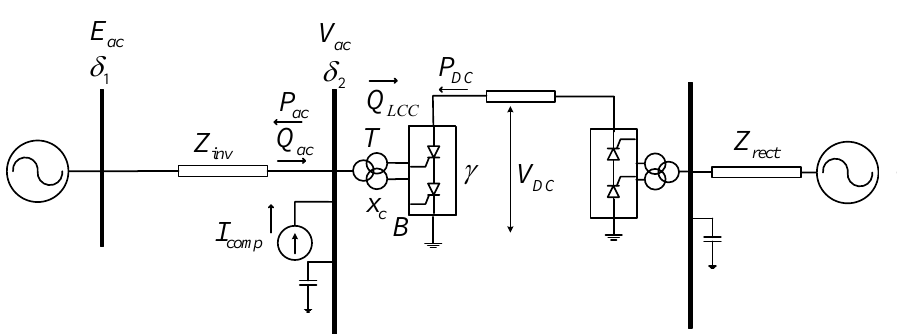
Figure 9. Equivalent AC/DC connection and its parameters for